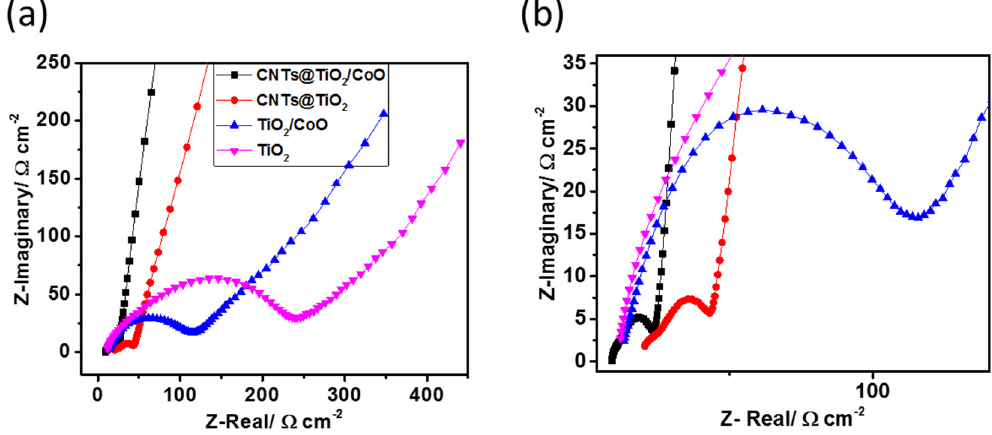
Figure 7. Nyquist plots of pure TiO 2 NTs (pink triangles), TiO 2 /CoO NTs (blue triangles), TiO 2 NTs covered with CNTs (red circles), and TiO 2 /CoO NTs covered with CNTs (black squares) (after 50 charging/discharging cycles, in the frequency range of 100 kHz to 0.1 Hz at a potential of 1.7 V vs. Li/Li + ) ( a ); zoomed view of Figure 7a ( b ).